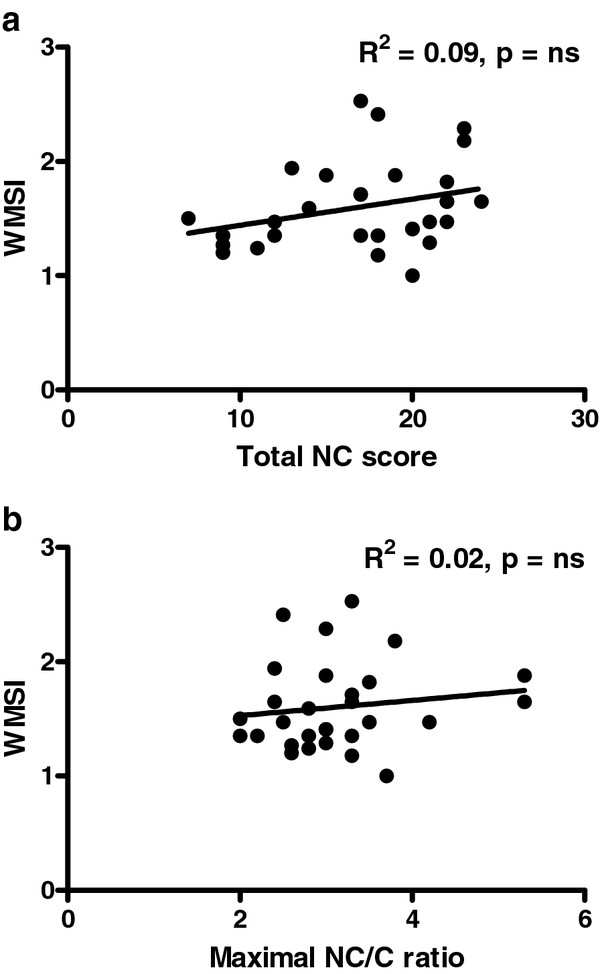
Relation between the wall motion score index and the total noncompaction score (2a), and the maximal noncompaction score (2b).